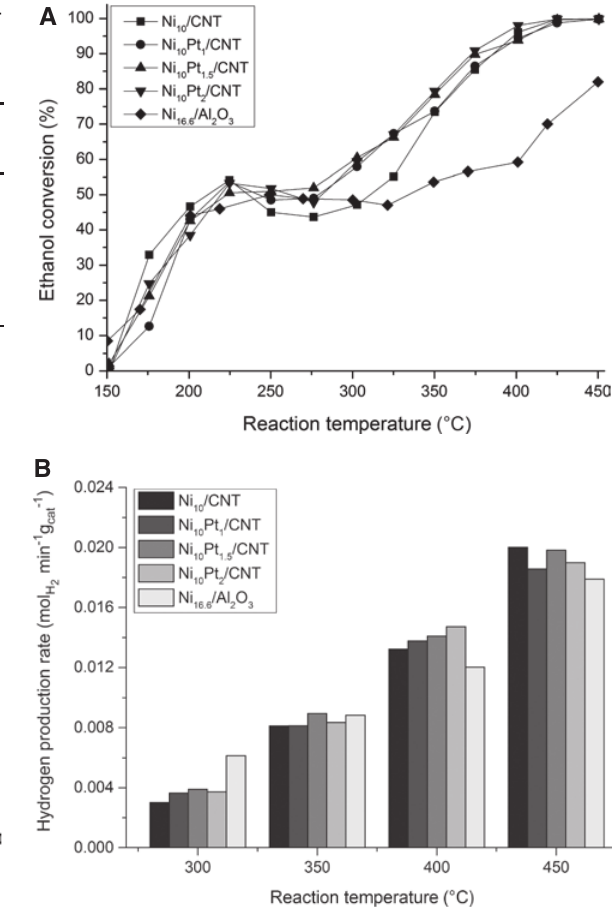
Figure 4: The effect of Pt addition on (A) ethanol conversion and (b) hydrogen production rate (in terms of mol of reaction temperature for Ni wt.%, 1 wt.%, 1.5 wt.% and 2 wt.%) and the reference catalysts in steam reforming of ethanol